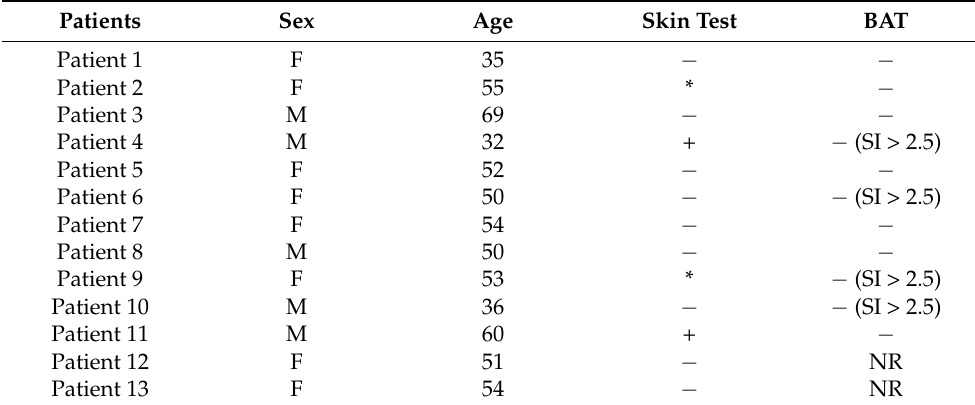
Table 1. General characteristics of patients and hypersensitivity reactions to